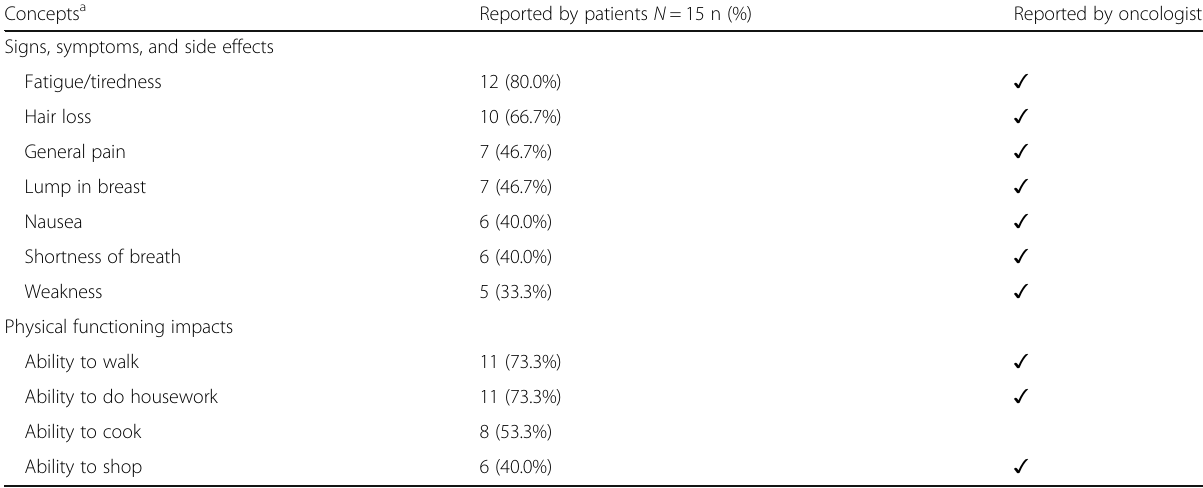
Table 6 Concept tracking matrix: Concepts reported by patients and experienced oncologists Concepts a Signs, symptoms, and side